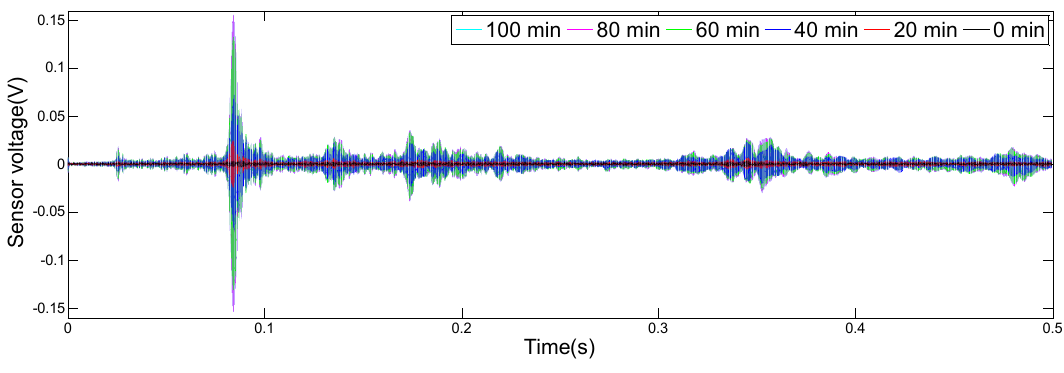
Figure 8. Signal received by PZT1 (0–100 min).